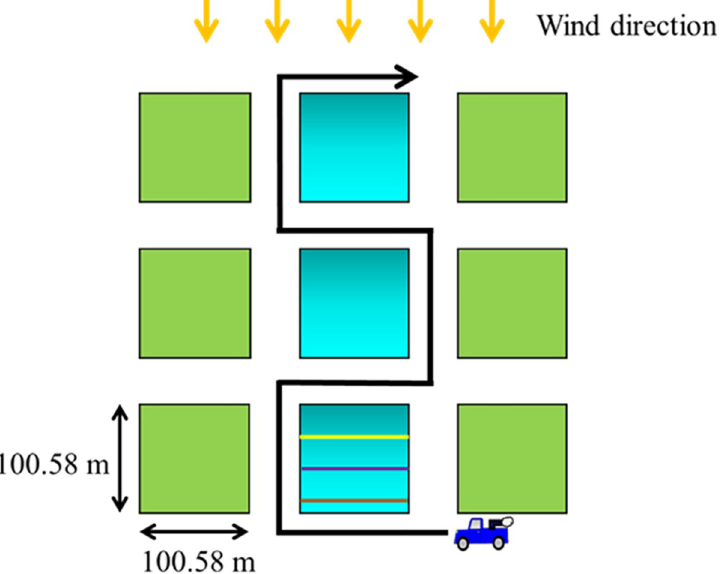
Fig 12. Schematic of pesticide application route in Harris County. The average length of blocks (colored squares) in Houston is 100.58 m. The orange arrows indicate the wind direction. The black single arrow line shows the route of the pesticide application truck. The green squares are the blocks that have not received pesticide application. The squares with blue gradient are the blocks that have received the pesticide application; based on the bioassays results, the darker blue region receives more pesticide droplets than the lighter blue region. The three different colored lines in the gradient blue block indicates the three different distances, 30.4 (yellow line), 60.8 (purple line), and 91.4 (brown line) meters, from the pesticide application